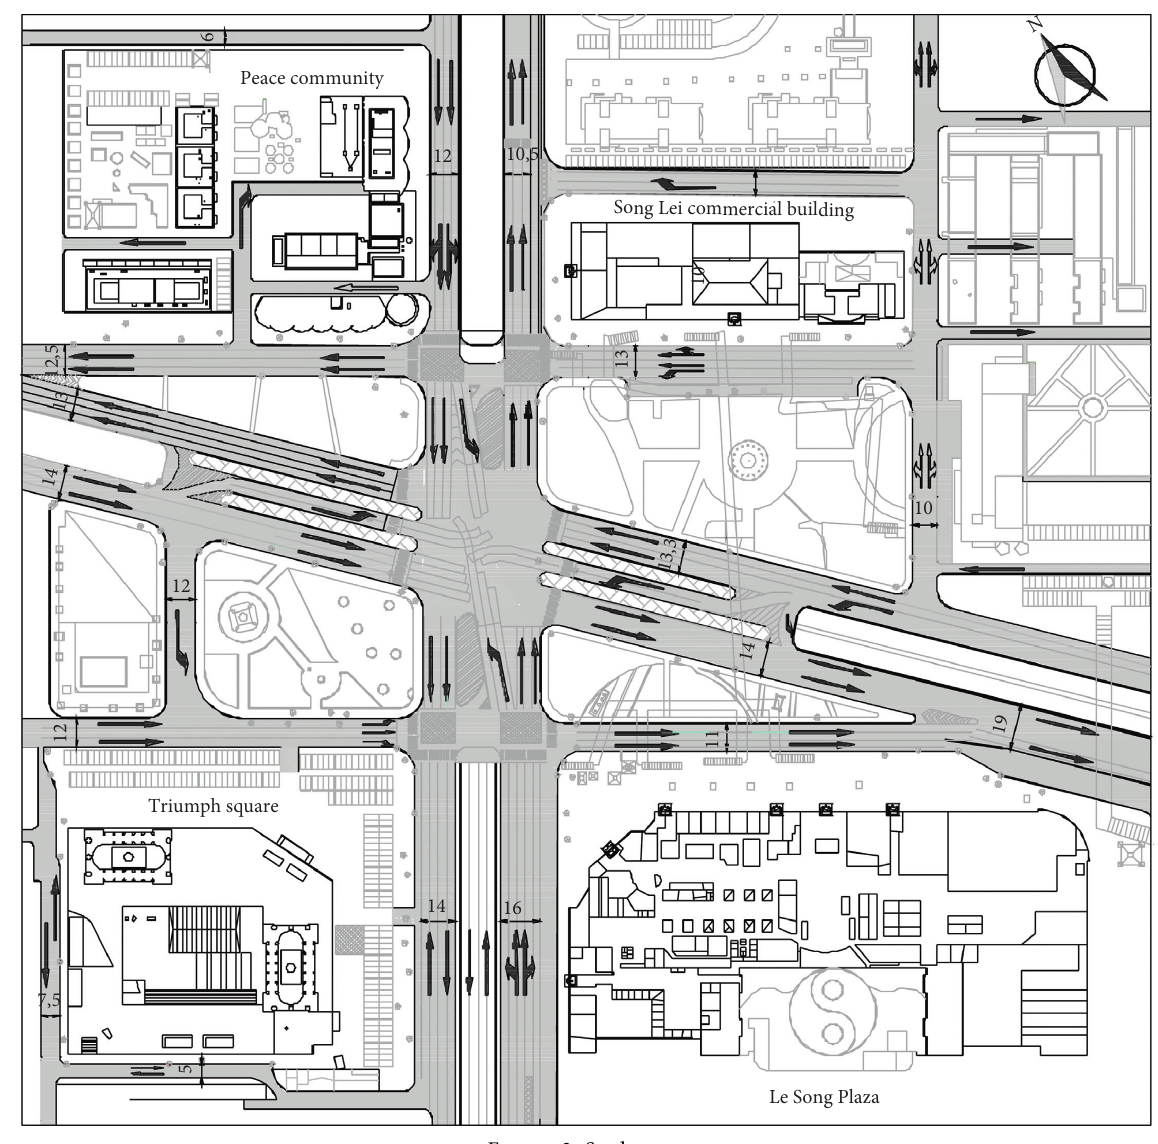
Figure 2: Study area.